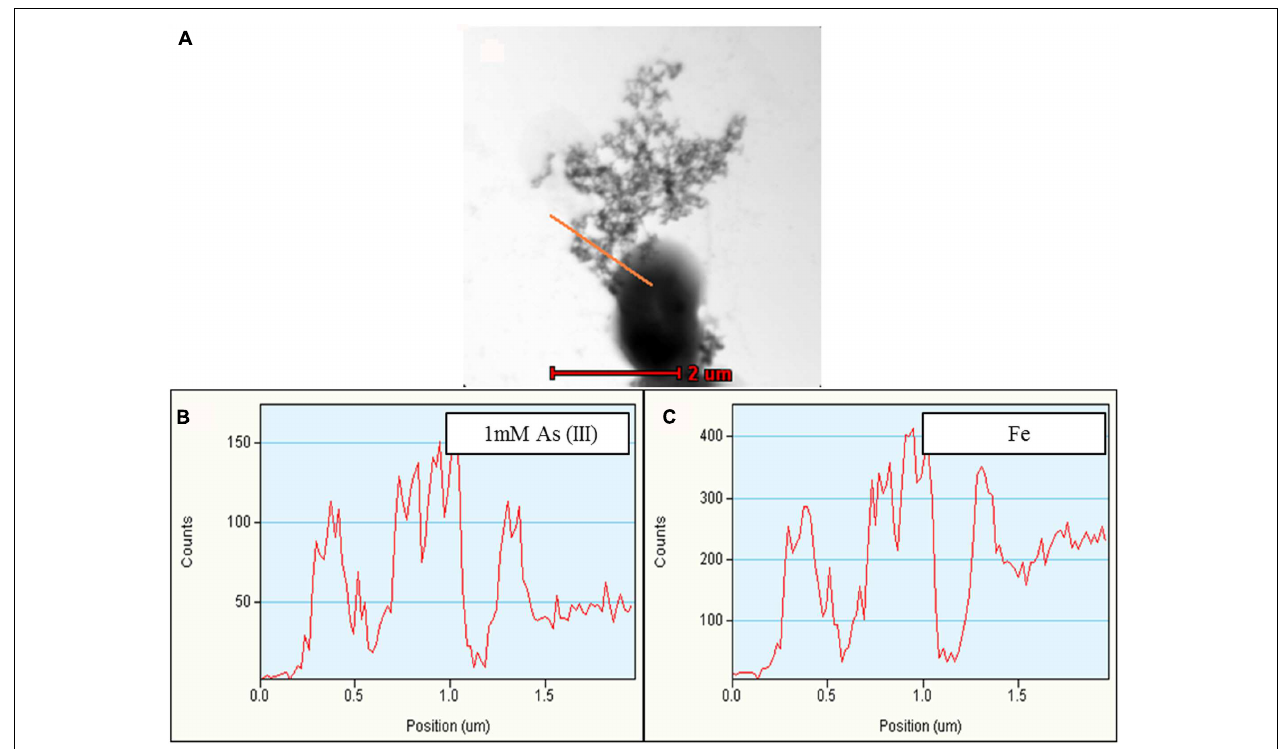
FIGURE 6 | Representative TEM-EDX analysis of Synechocystis cells treated with 1 mM As (III). Putative TFP-As complexes were observed on Synechocystis cells (A) , which is confirmed by line EDX (highlighted by red line in A ). (B,C) Fe was also observed along with As. Higher concentration of As was observed on putative TFP-As complexes than that of the cell. Line EDX data was collected from left to right direction (i.e., from top to